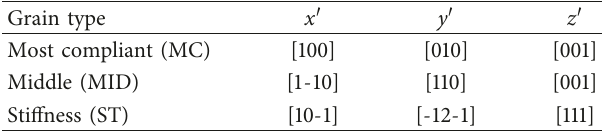
Figure 3: Selected crystallographic directions for analysis. Table 1: Crystal orientations considered for grains.